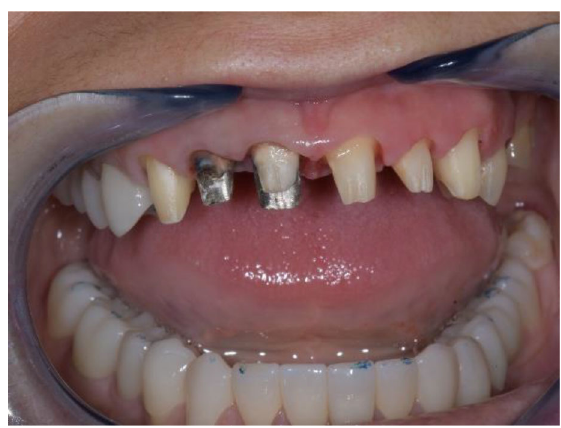
Figure 19. Zirconia prosthesis in the patient ’ s mouth (try-in procedure).